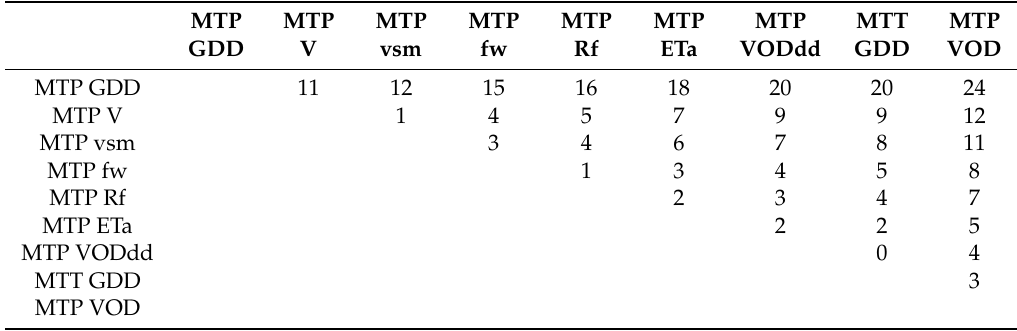
Table 3. MTP lag in weeks between each variable averaged in space and time (2003–2015) for Ethiopian sites. Note that these lags can vary in space and time for particular sites.